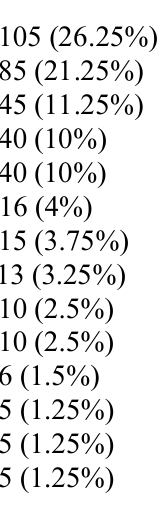
Table 5: Indications of Cesarean